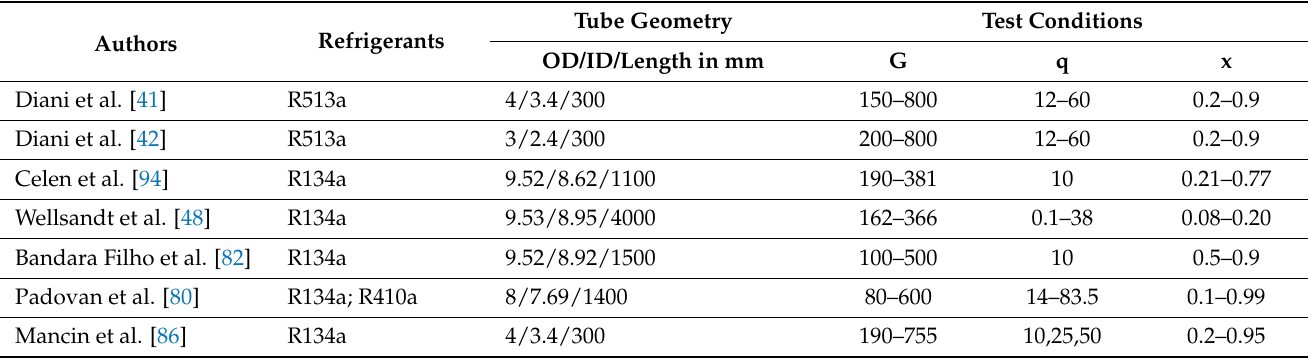
Table 4. Comparison of experimental conditions of different authors regarding results shown above for refrigerants R134a and R513a in micro-finned